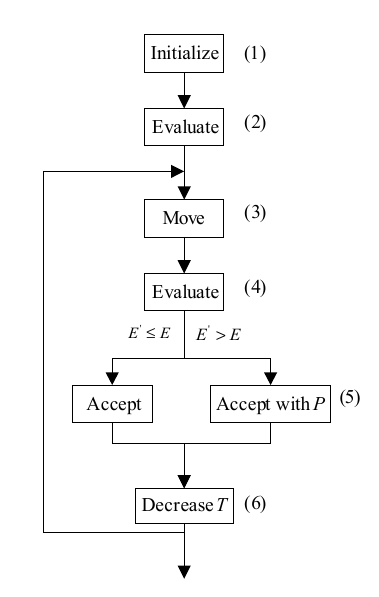
Fig. 2. Flow chart of basic SA